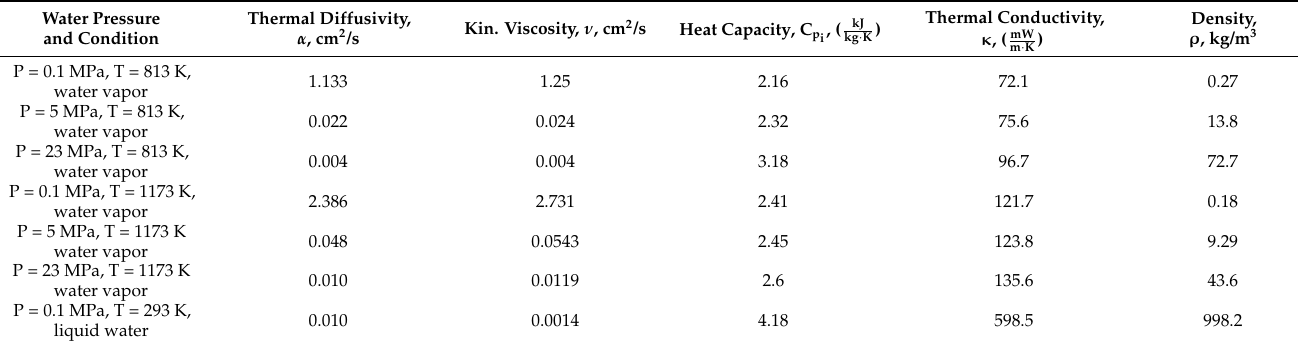
Table 1. Comparison of the thermophysical properties of water